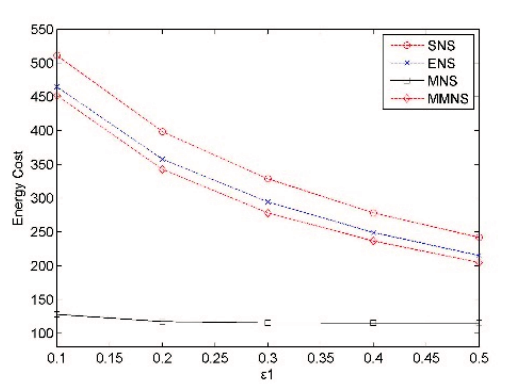
Figure 4. The impact of the ɛ 1 on the energy